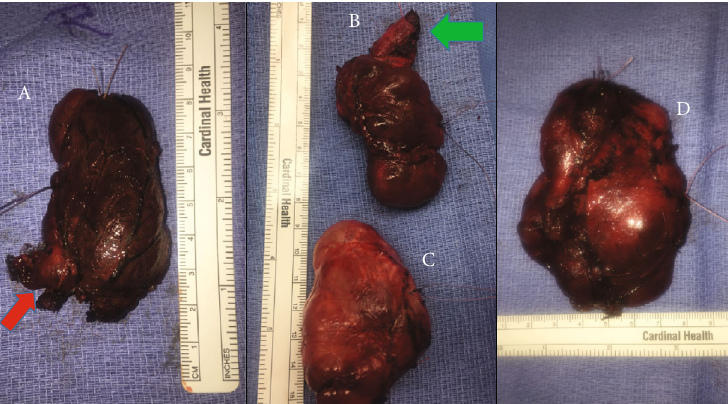
Figure 3: (A) The right multinodular thyroid lobe with inferior pole tail-like extension measuring 8 × 4 × 3 cm. Note the tail-like extended protrusion (red arrow). (B) Posterior ectopic thyroid measuring 8 × 5 × 2 cm. Note the teardrop shape resembling a remnant tract on the superior end (green arrow). (C) Substernal ectopic thyroid measuring 6 × 5 × 3 : 5 cm. (D) Left thyroid lobe measuring 8 × 5 × 2